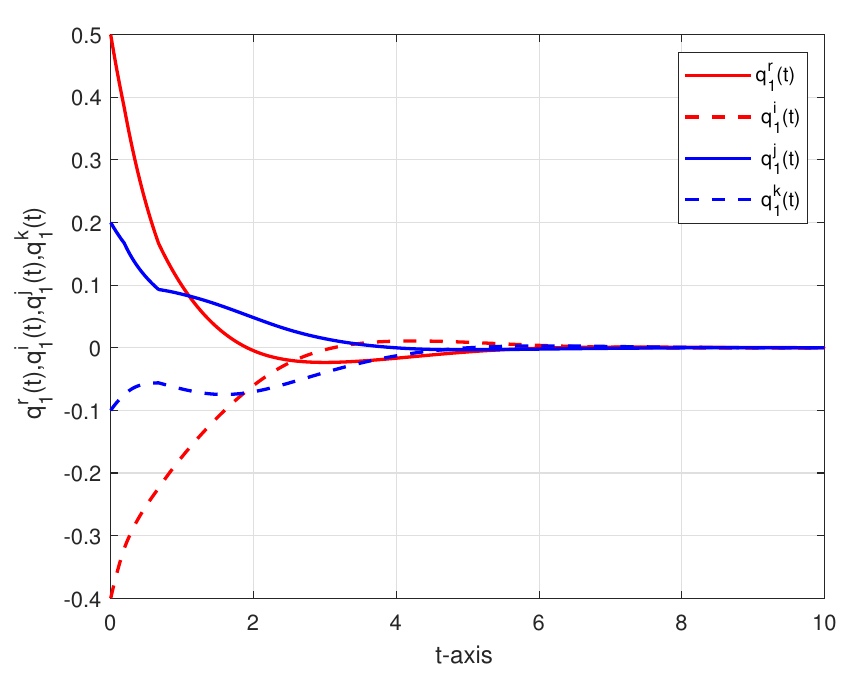
Figure 1. State trajectory of four parts of q 1 ( t ) for system